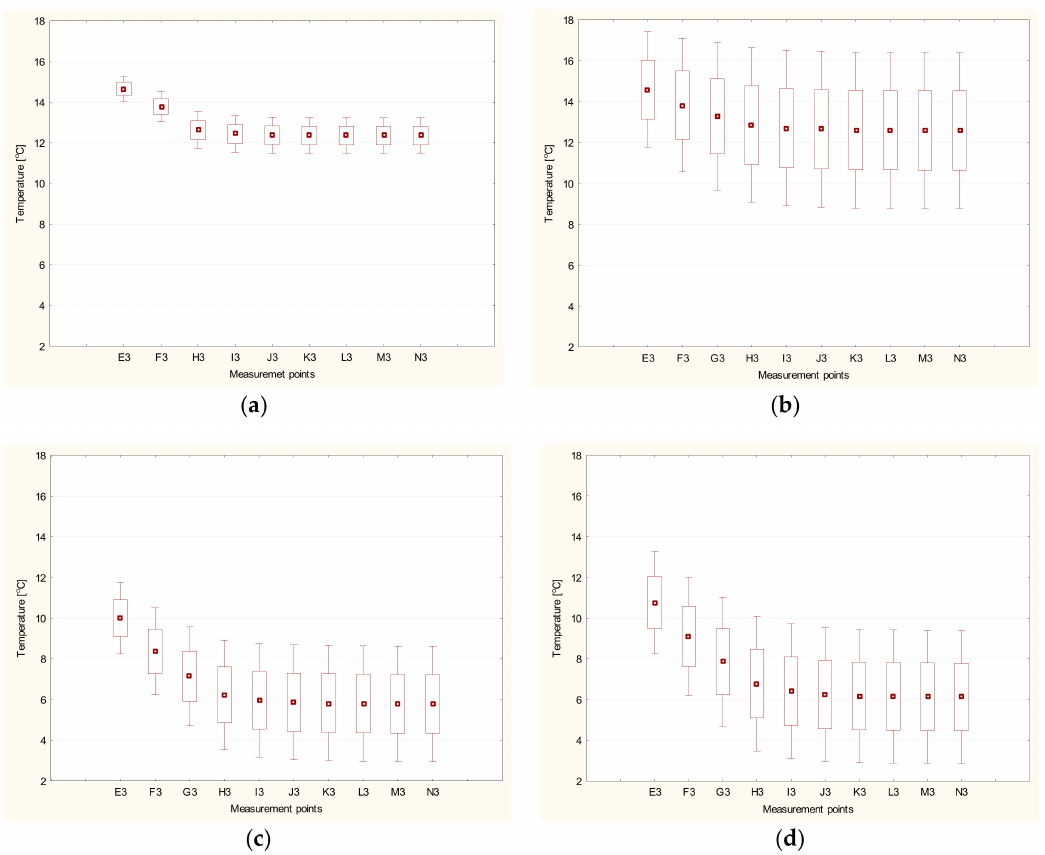
Figure 8. Soil temperatures in selected measurement points located in the soil surrounding the building at a depth of 1.00 m in ( a ) summer, ( b ) autumn, ( c ) winter, and ( d ) spring.